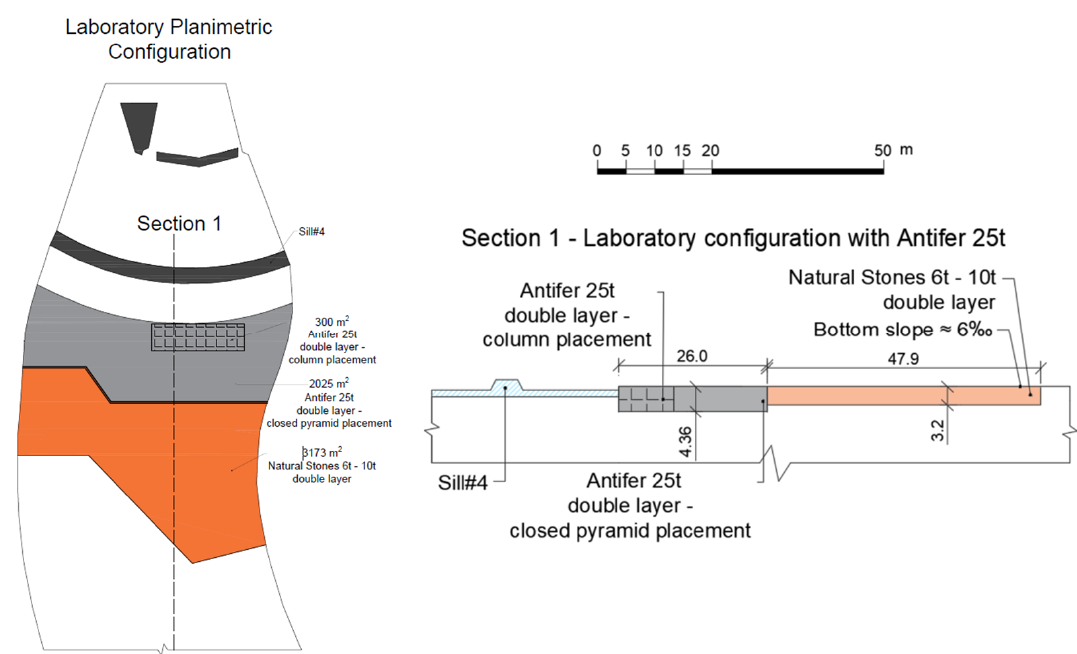
Figure 7. Scheme of the laboratory model in which the protection of the riverbed is realized with Antifer blocks (25 t in prototype scale) placed downstream of the stilling basin. Dimensions in prototype scale.